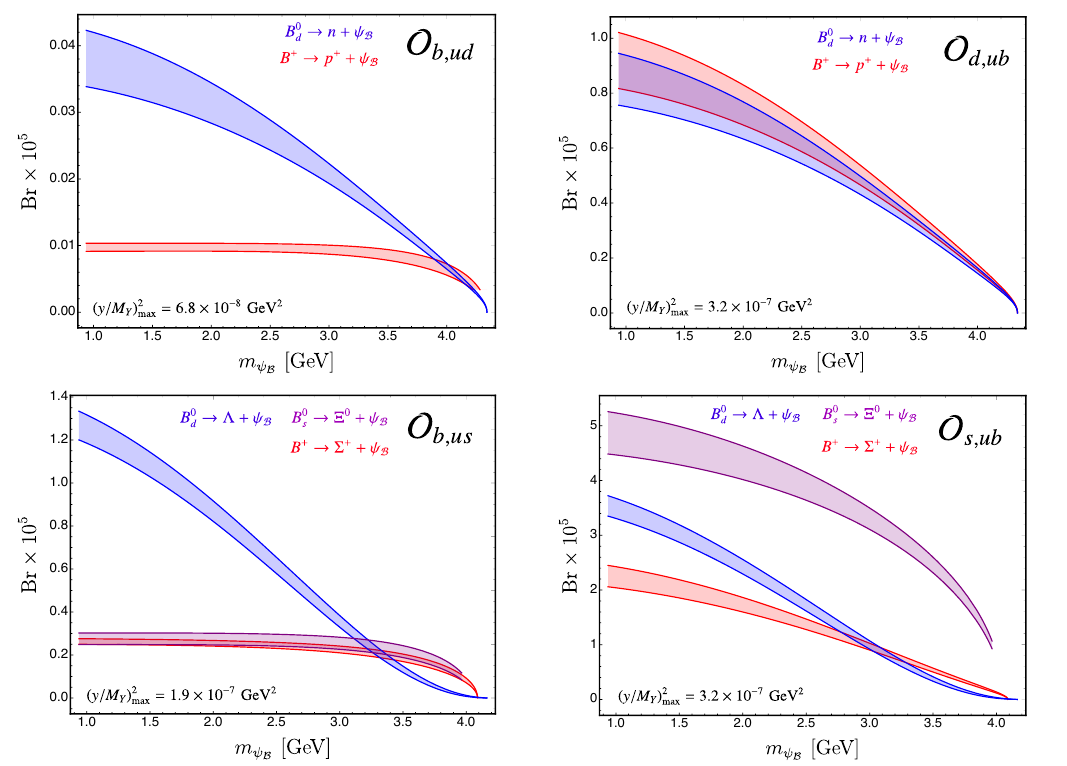
Figure 2 . Branching fractions as a function of ψ B mass for the decays arising from the light quark operators ψ B b u d and ψ B b u s ; the top two rows of table 1. For each operator, we have fixed the Wilson coefficient to the maximum possible value allowed by LHC constraints, computed in [9]. The error bands come primarily from the uncertainties in the DAs and the errors on the internal parameters, as discussed in the